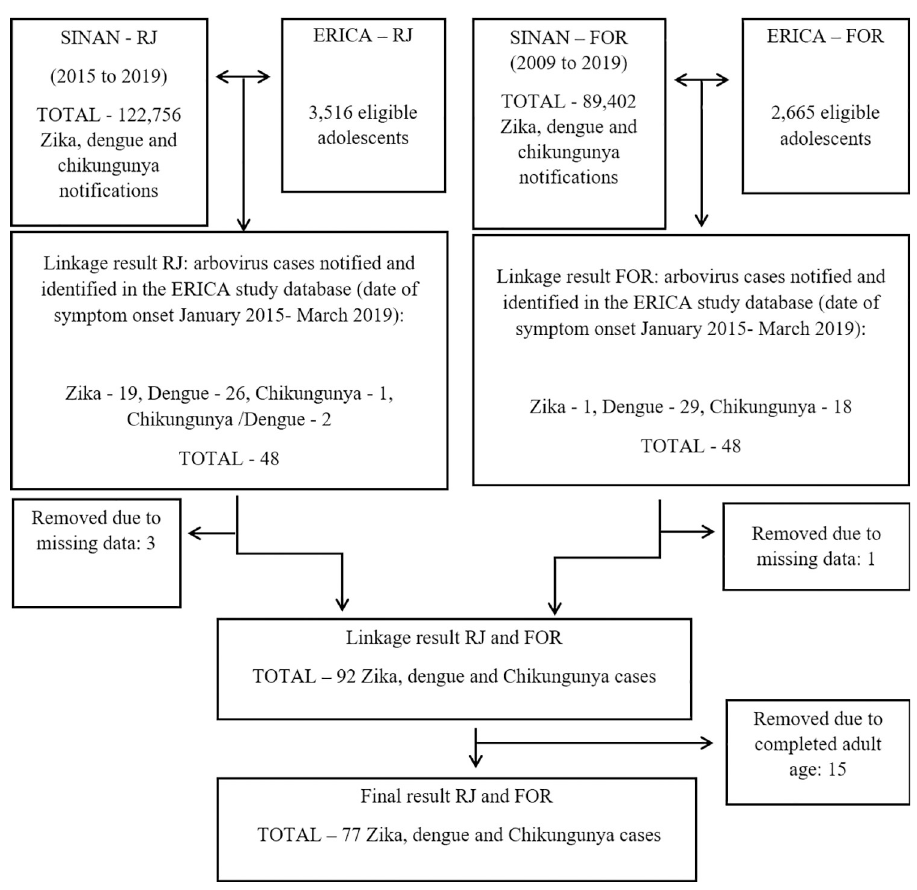
Fig 1. Flowchart of the data linkage for the cities of Rio de Janeiro/RJ and Fortaleza/CE.